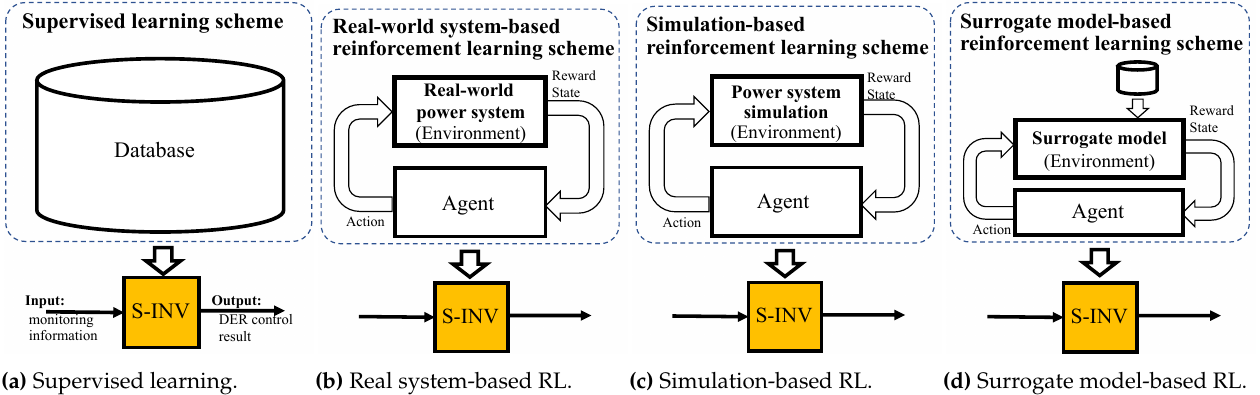
Figure 4. Variations of learning schemes for S-INV control